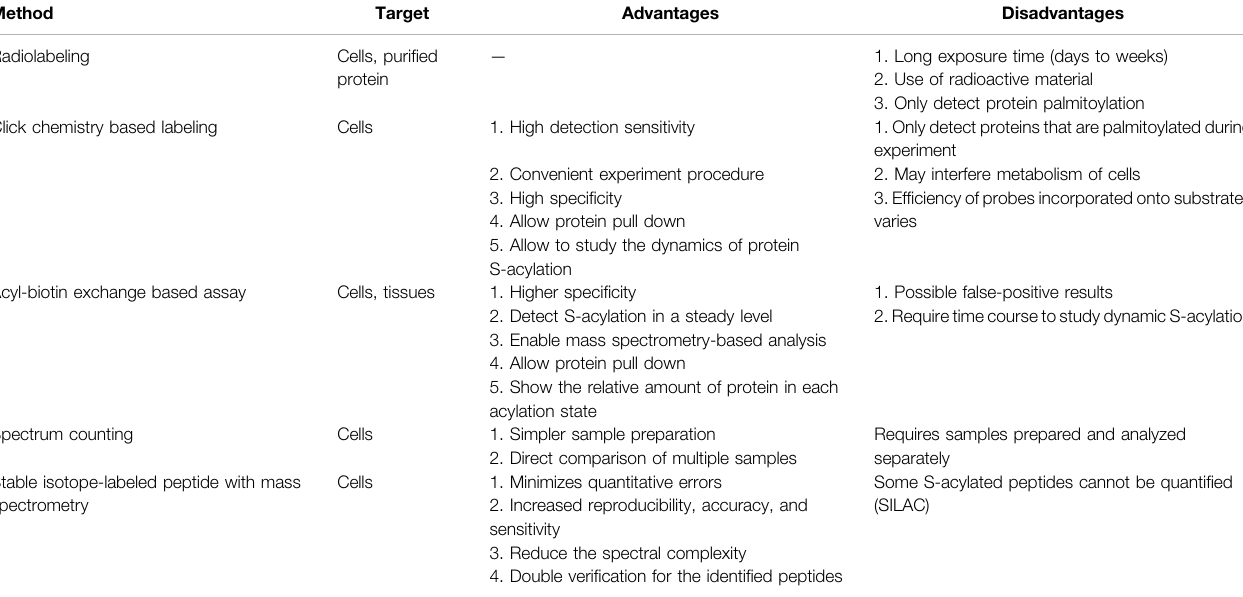
TABLE 1 | Comparison of different methods detecting S-acylation. Selected methods are listed above with their targets, advantages, and